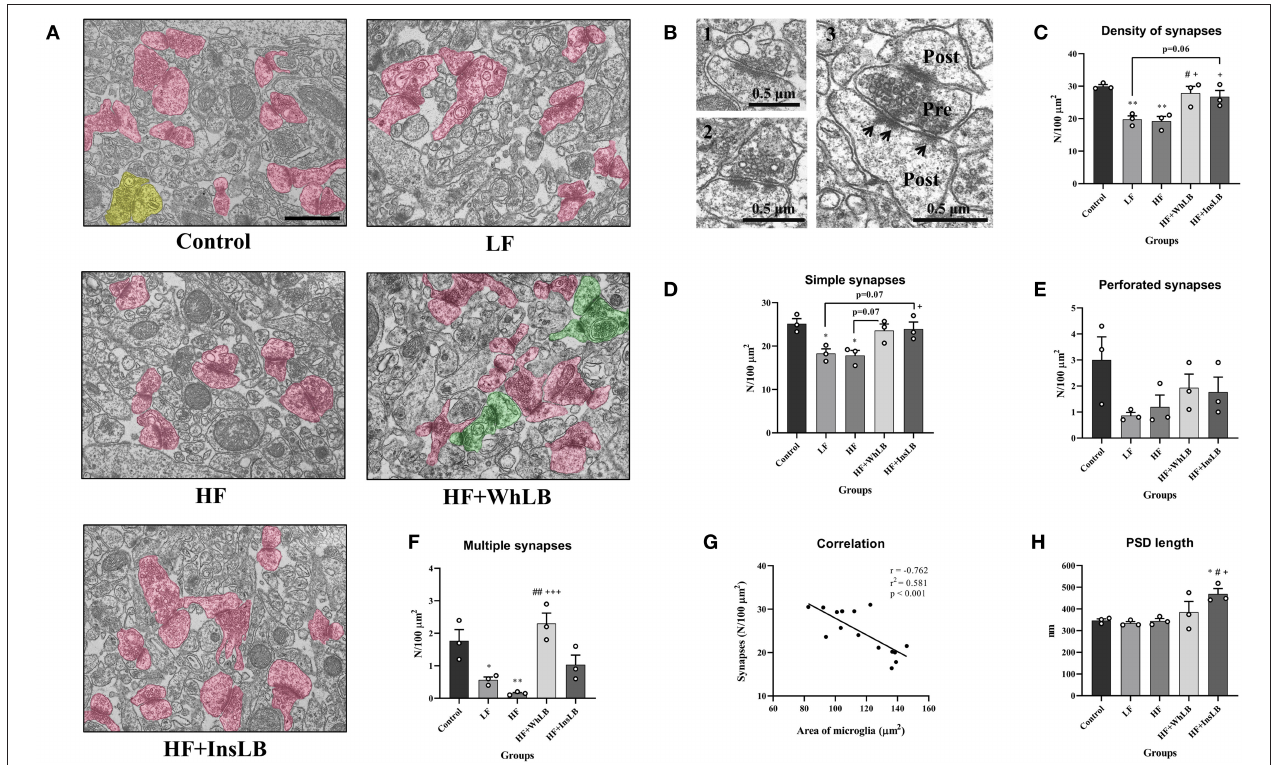
FIGURE 5 | Electron microscopic analyses of the stratum radiatum in the hippocampal CA1 area of distinct experimental groups. (A) Electron micrographs of the neuropil ultrastructure. Different types of synaptic contacts are marked in various colors, as follows: simple—pink, perforated—yellow, multiple—green. (B) Representative images of (1) simple, (2) perforated, and (3) multiple synaptic types. Pre, presynaptic terminal; Post, postsynaptic terminal: Arrows point to the postsynaptic density. (C) The density of synapses and (D) the number of simple, (E) perforated, and (F) multiple synaptic contacts per 100 µ m 2 of hippocampal neuropil. (G) Pearson’s correlative analysis between the area of microglial cells and synaptic density. (H) The average length of the postsynaptic density. Data are expressed as the Mean ± SEM ( n = 3/group). Comparisons among groups were performed with the one-way ANOVA, followed by Turkey’s post hoc test. * p < 0.05 and ** p < 0.01 indicate significant differences vs. control; # p < 0.05 and ## p < 0.01 indicate significant differences vs. LF; + p < 0.05 and +++ p < 0.01 indicate significant differences vs. HF. The scale bar corresponds to 1 µ